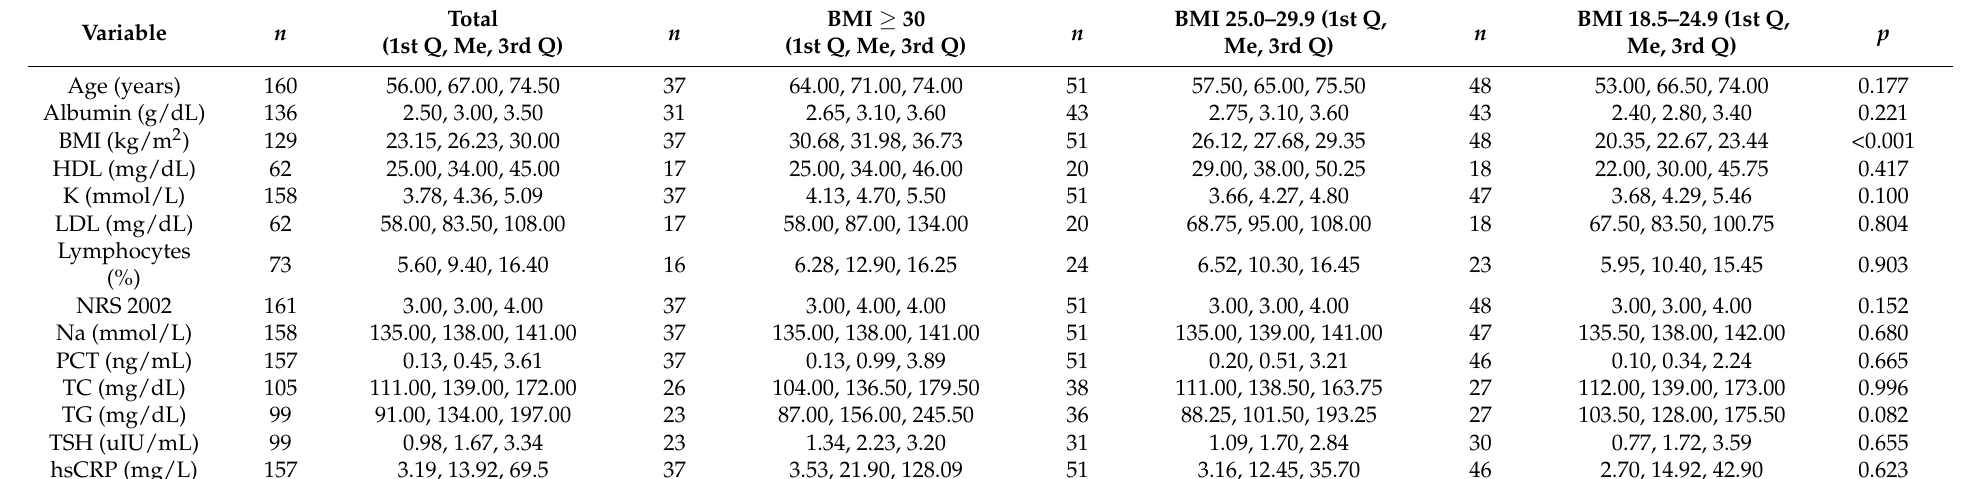
Table 1. Characteristics of the sample population, by BMI value (continuous